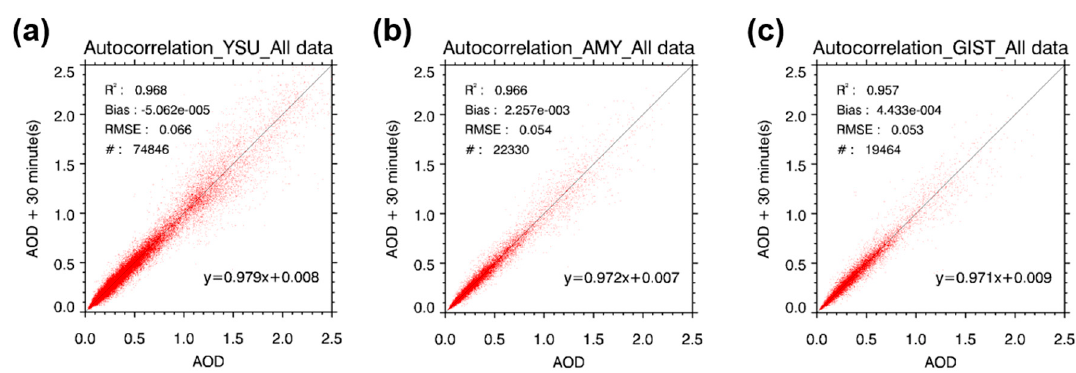
Figure 3. Temporal variability of AOD for 30 min time lag from Sunphotometer at ( a ) Yonsei University, ( b ) Anmyeon, and ( c ) GIST.